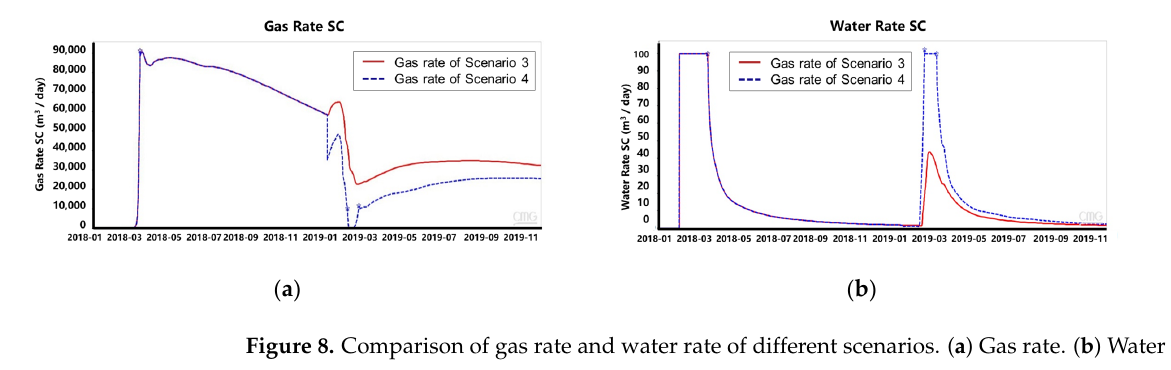
Figure 9. Water saturation distribution of multi-well system. ( a ) Fracture connectivity of 40%. ( b ) Fracture connectivity of 80%.